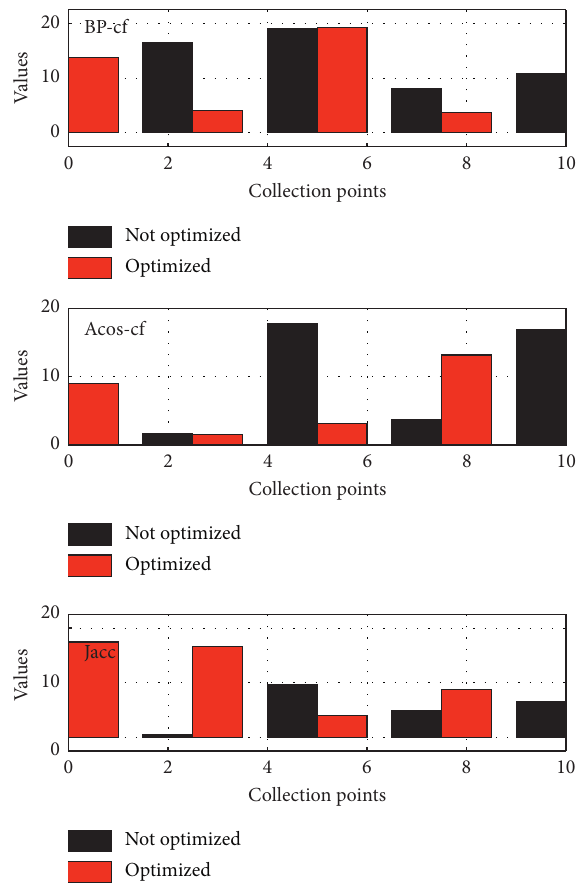
Figure 8: Comparison of MAE by the